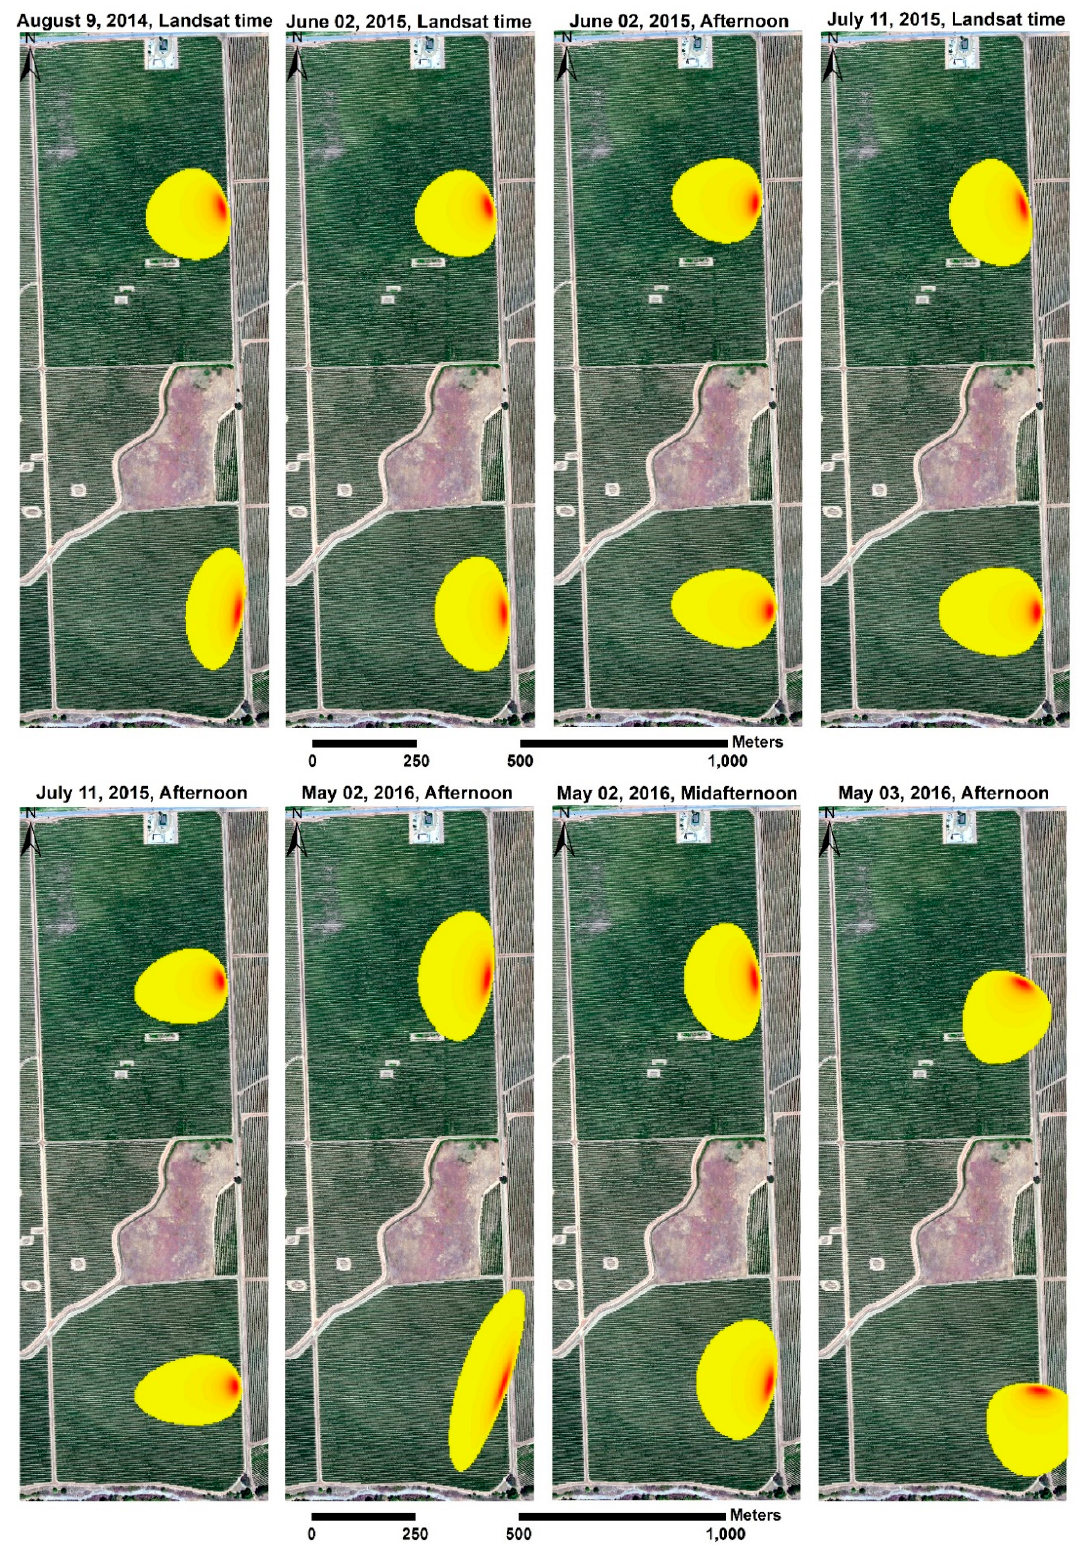
Figure 5. Layout of 90% EC footprints for two towers at di ff erent times considered by this